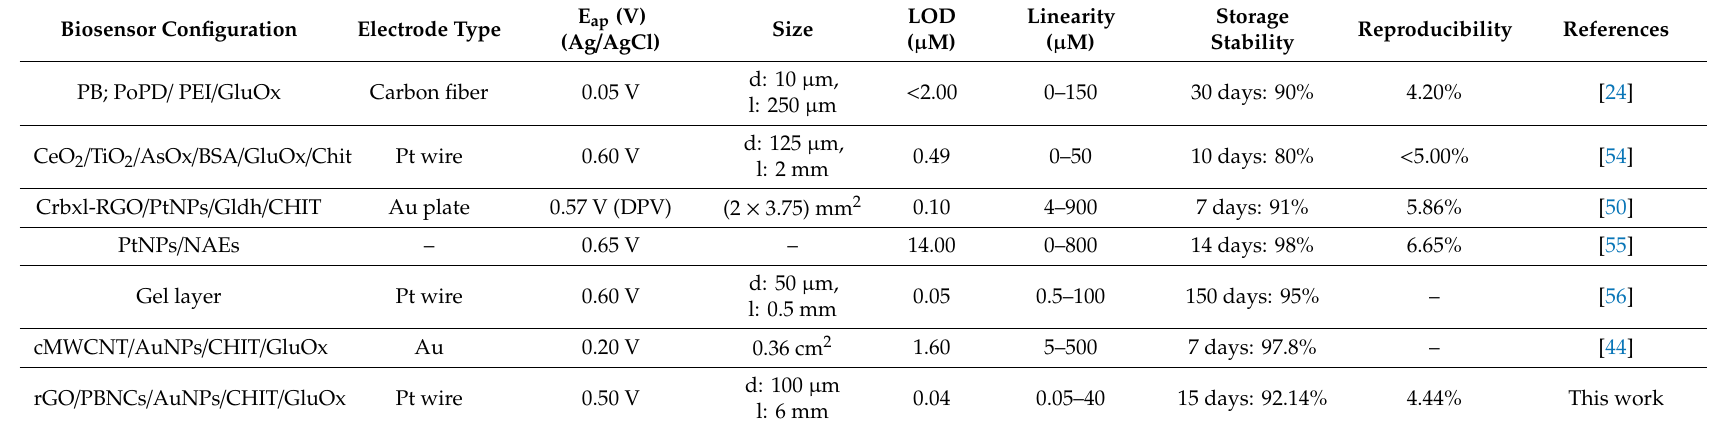
Table 1. Characteristics of various electrochemical microbiosensors reported for glutamate